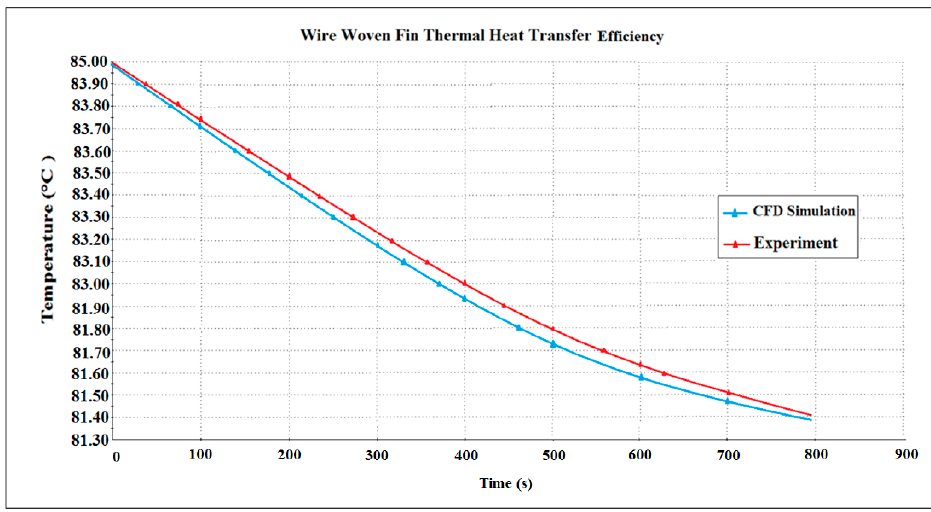
Figure 26. Variations of heat transfer over time.